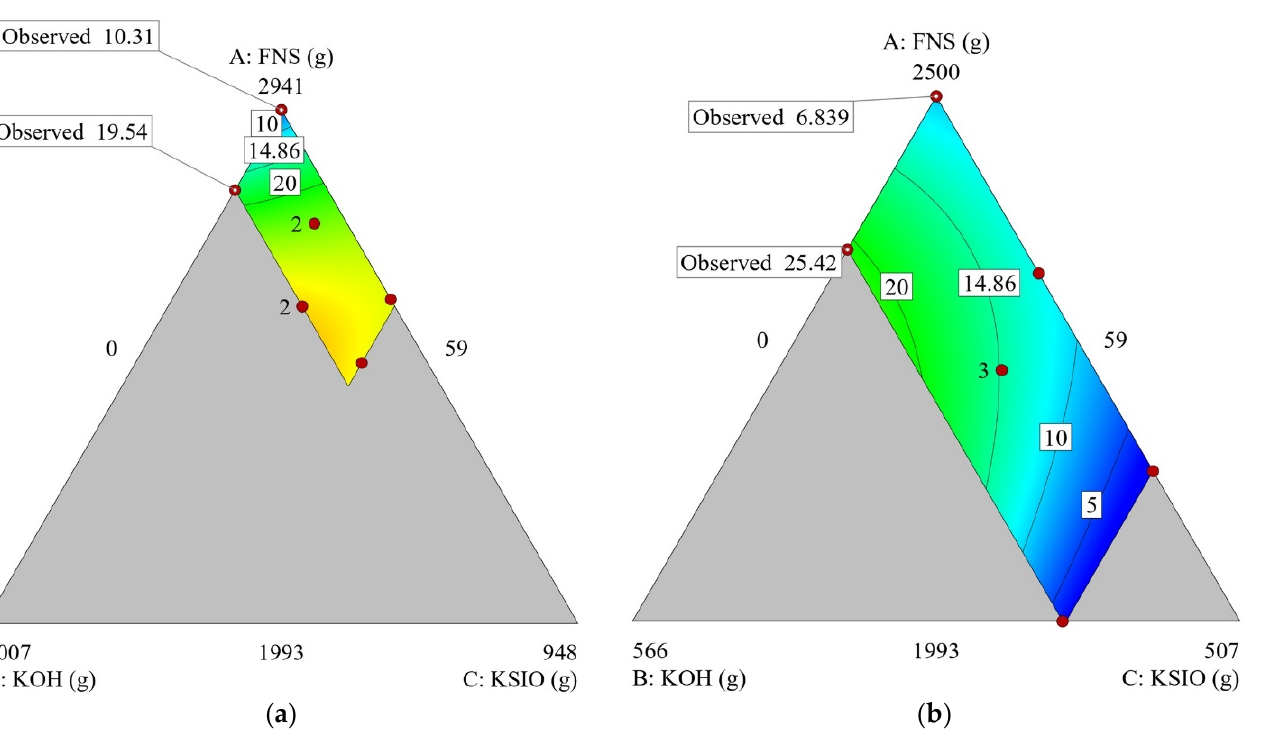
Figure 2. Example contour graphs of post-heating residual compressive strengths as a function of the contents of components A, B, and C, with component D fixed to its: ( a ) lower bound (0 g), ( b ) upper bound (441 g). The mix sums to 3000 g.